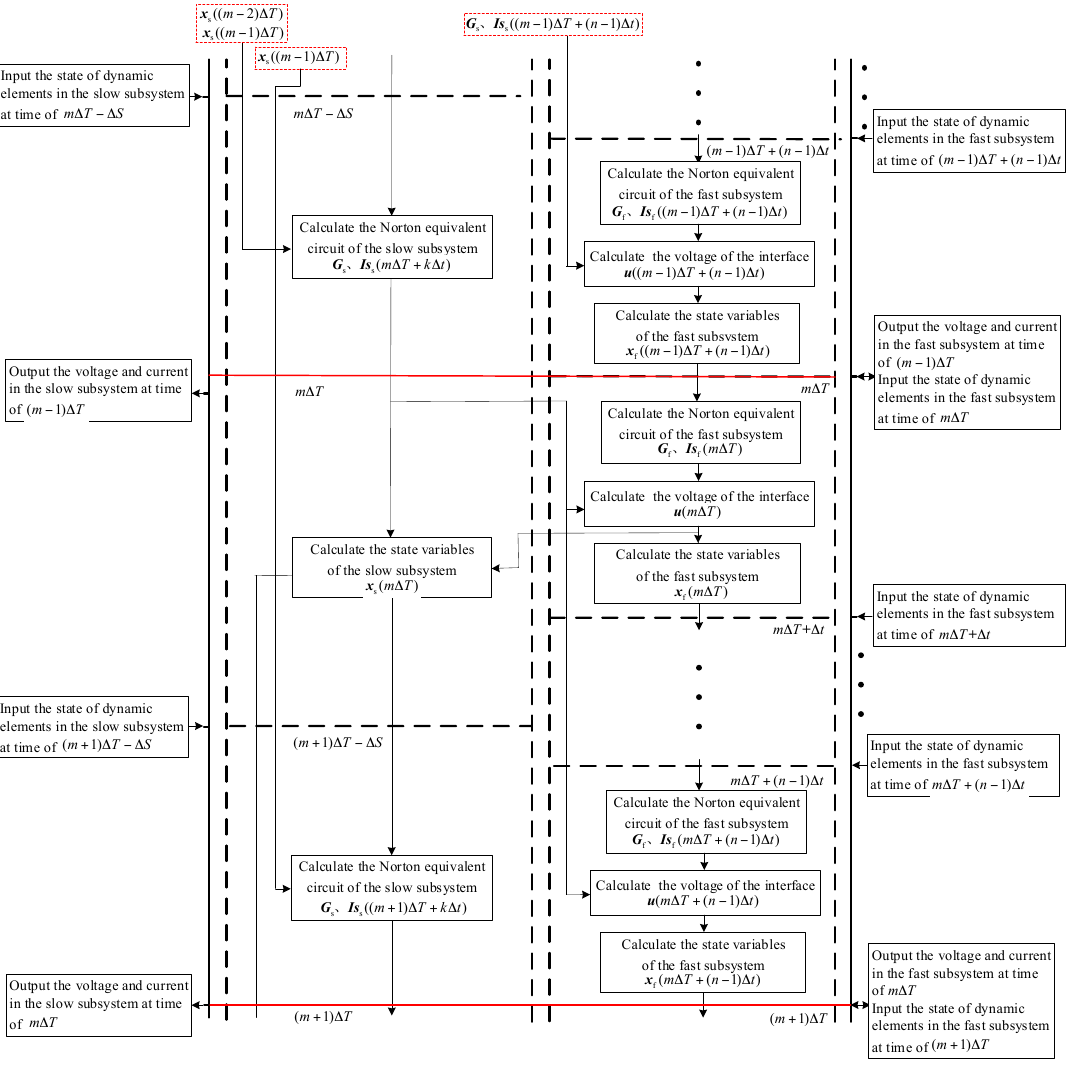
Figure 5. The time of input and output and the logical relationship of calculation tasks with multi-rate real-time simulation method based on the Norton equivalent.